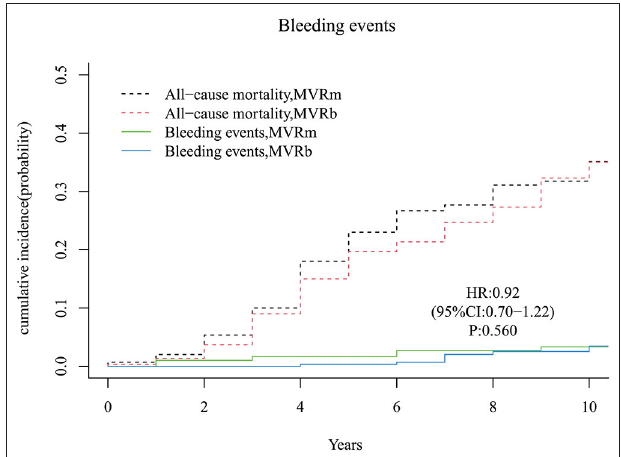
FIGURE 9 | Cumulative incidence of major bleeding events. MVRm, mechanical mitral valve replacement; MVRb, bioprosthetic mitral valve replacement.